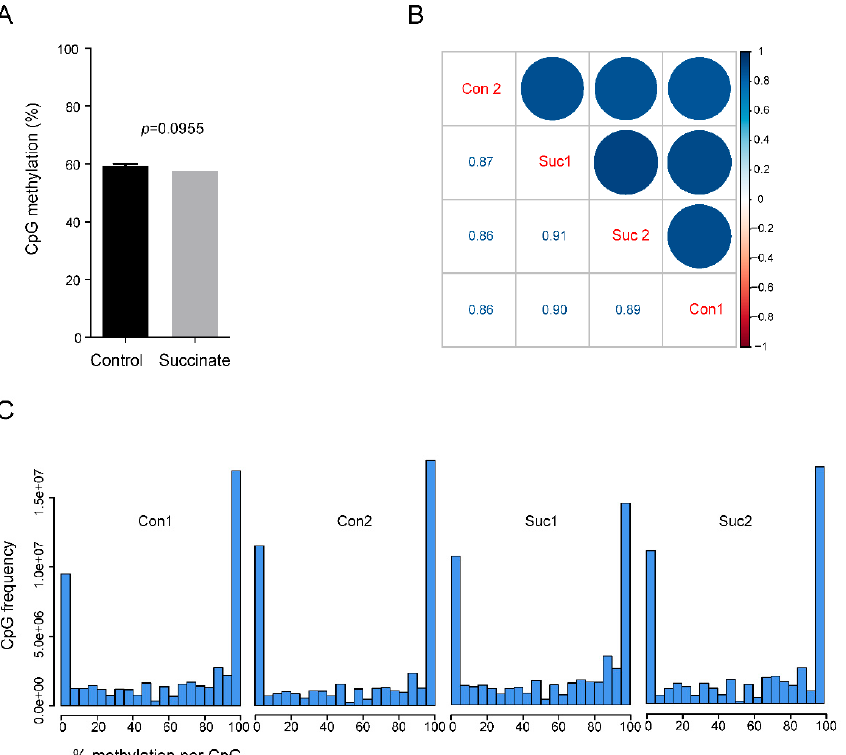
Figure 2. Whole-genome bisulfite sequencing of control and succinate-treated bronchial epithelial cells. ( A ) Genome-wide CpG methylation levels in control and succinate-treated bronchial cells. The bar graphs represent the % CpG methylation. ( B ) The correlogram shows the correlation of genome-wide CpG methylation between the controls (i.e., Con1 and Con2) and succinate treatment groups (i.e., Suc1 and Suc2). Sample names are shown on the diagonal. Below the diagonal are the values of Pearson correlation between samples. On the top of the diagonal, correlations are displayed in color. Color intensity and the size of the circle are proportional to the correlation coefficients. At the right side of the correlogram, the legend color shows the correlation coefficients and the corresponding colors. ( C ) The histograms show the genomic frequencies of CpG sites at each ranked methylation level (0–100% as shown on the x -axis) for each sample. The y -axis shows the frequencies of the CpG sites within the indicated range of methylation levels. Most of the sites had either high or low methylation